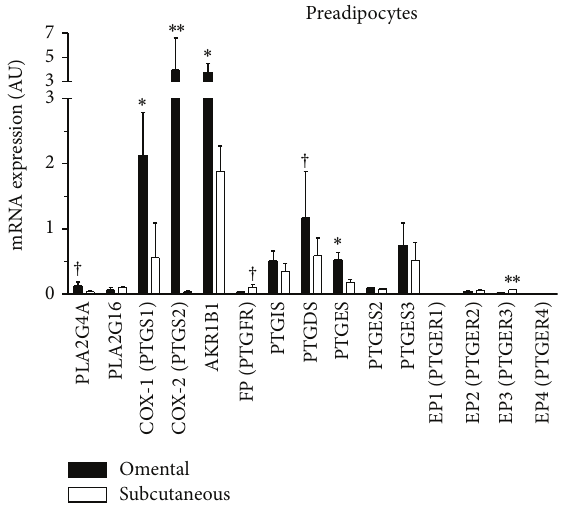
Figure 3: Omental ( 𝑛 = 4 ) and subcutaneous ( 𝑛 = 5 ) preadipocyte mRNA expression of several transcripts coding for PG receptors or enzymes involved in PG synthesis. Expression levels relative to G6PD mRNA abundance are shown. PLA2G4 (phospholi- pase A2), PLA2G16 (phospholipase A2), PTGS1 (cyclooxygenase 1), PTGS2 (cyclooxygenase 2), AKR1B1 (PGF synthase),